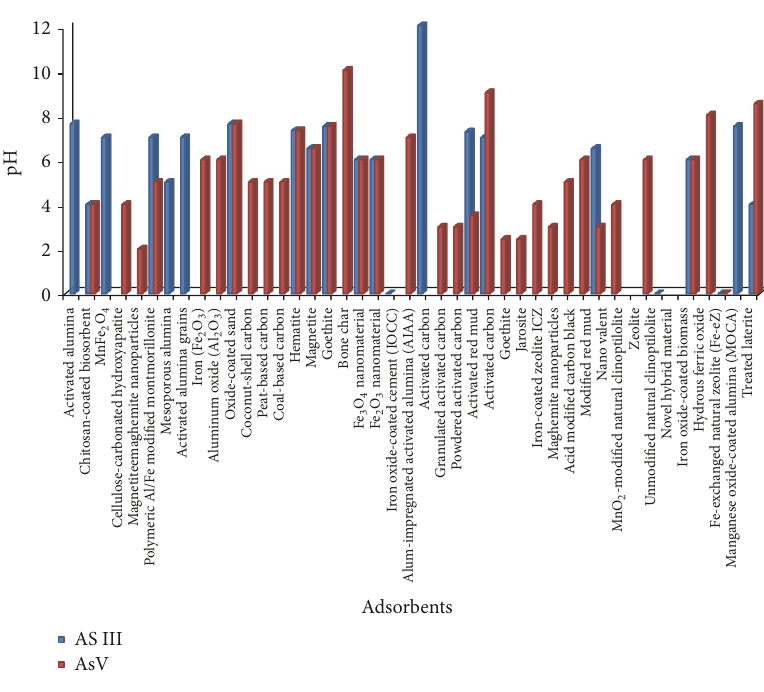
Figure 3: Effects of pH on As(V) and